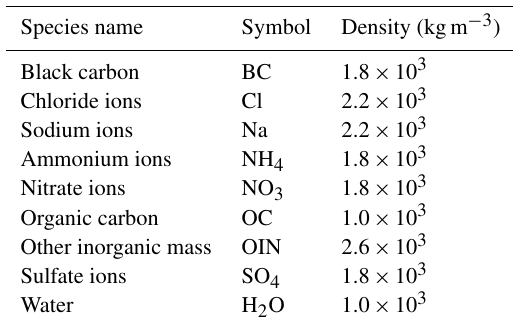
Table A4. Densities assumed for MOSAIC aerosol